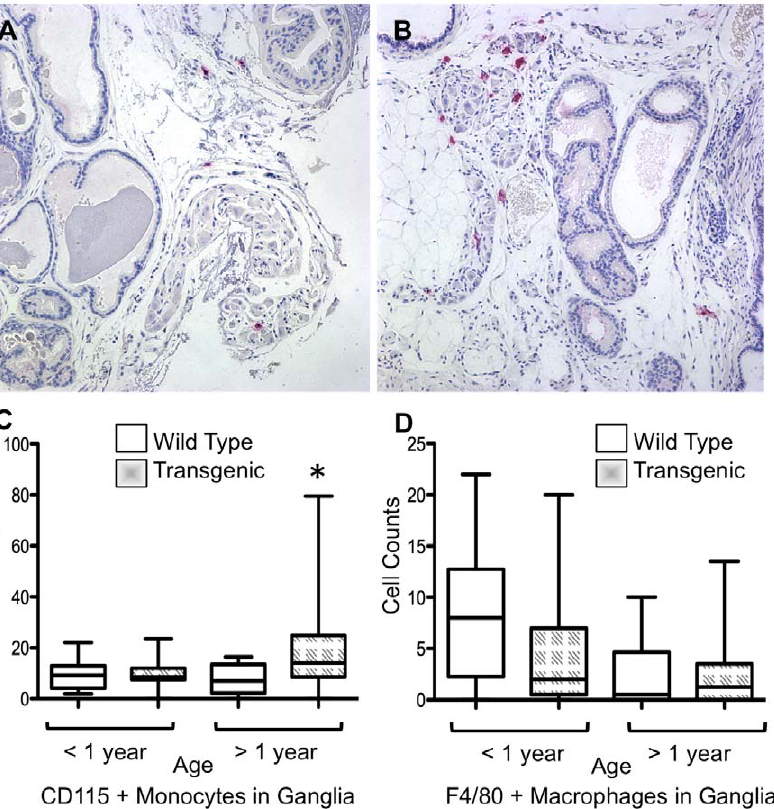
Figure 6. Recruitment of immature myeloid cells to parasympathetic ganglia is increased in TGF- b 1 transgenic mice. PanelsAandB. Inflammatory lesions demonstrate significantly greater recruitment of CD115 + myeloid cells to parasympathetic neurovascular bundles in transgenic mice ( PanelB ) compared to wildtype control ( PanelA ). PanelsCandD . Quantitation yields significantly greater CD115 + monocytes in transgenic compared to wildtype parasympathetic ganglia in mice over one year of age (* P , 0.05) ( PanelC ), whereas no significant differences in F4/80 staining is observed ( PanelD ). All images captured at 6 200.